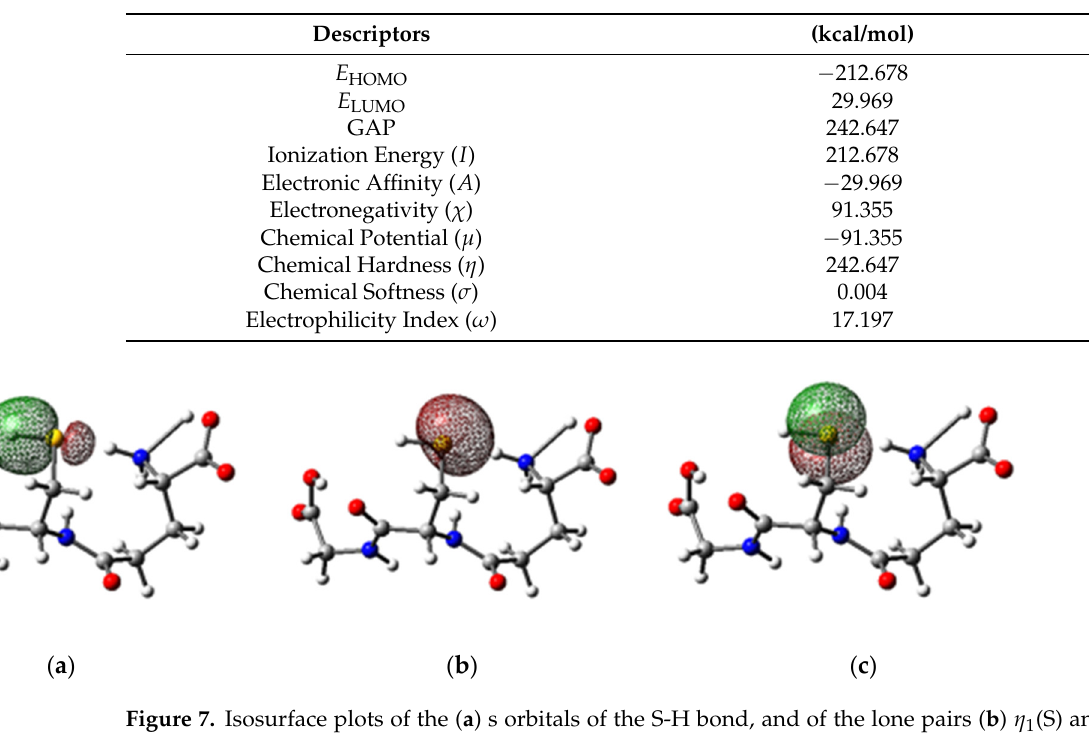
Figure 6. HOMO and LUMO plots for GSH calculated at the M06-2X/6-311++G(d,p) level of the- Table 3. Reactivity indices for the glutathione obtained at the M06-2X/6-311++G(d,p) level of theory. ory.